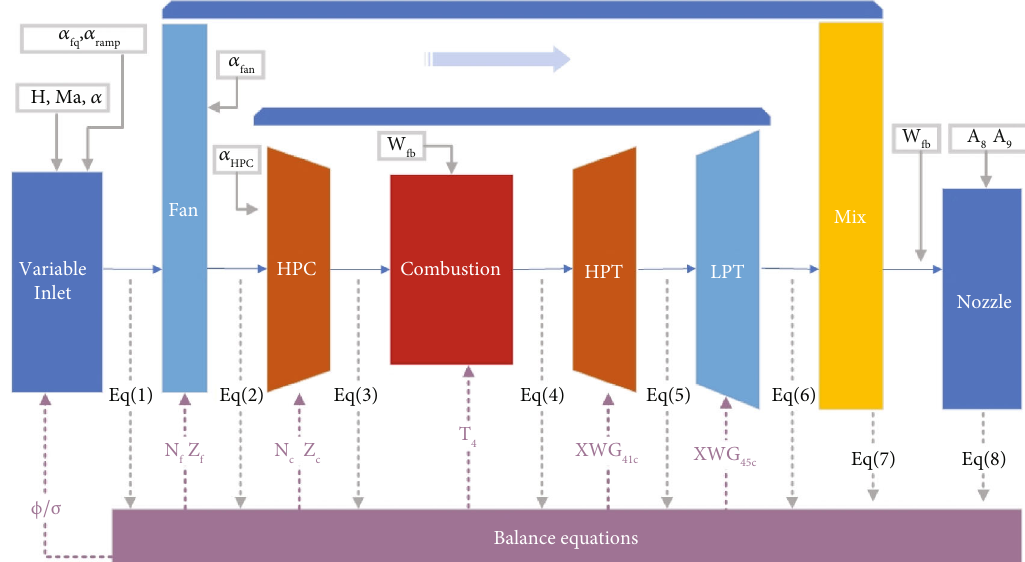
Figure 1: Calculation fl ow chart of inlet/engine integrated component level